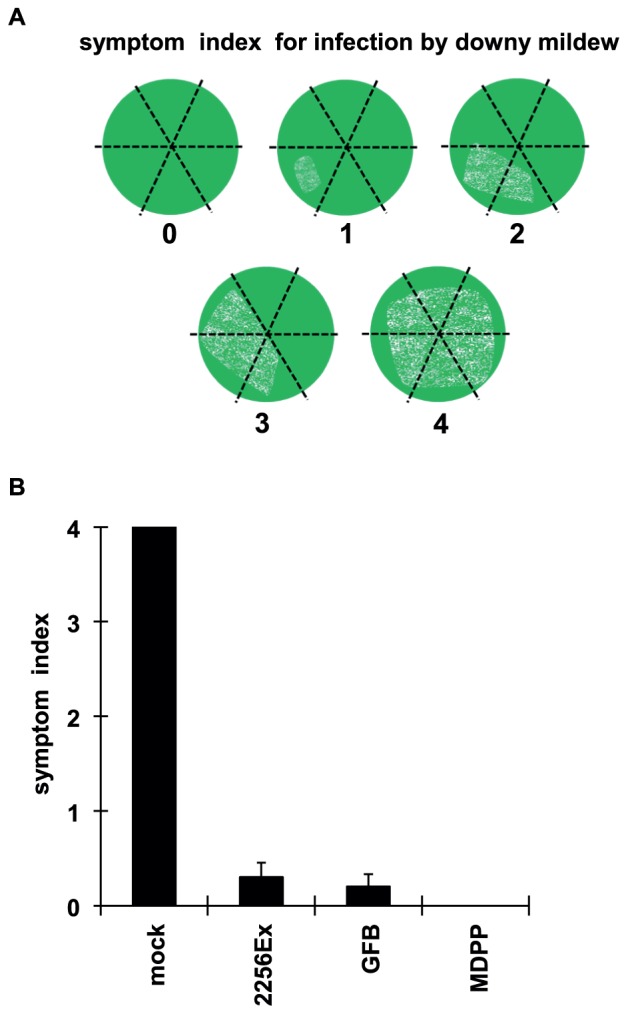
Glutamate fermentation by-product (GFB)-triggered defense response enhanced resistance to infection by downy mildew.(A) Leaf disks of Neo Muscat were treated with 2% GFB, 2 mg/mL 2256Ex, 3.3 mg/L mandipropamid (MDPP), or water (mock), and inoculated with P. viticola. After 7 days, infection was scored as: 0, no infection; 1, <1/6 of the leaf disk; 2, >1/6 but <1/3 of the leaf disk; 3, >1/3 but <1/2 of the leaf disk; 4, >1/2 of the leaf disk. (B) Evaluated symptoms. Data are means ± S.D. of 10 biological replicates.